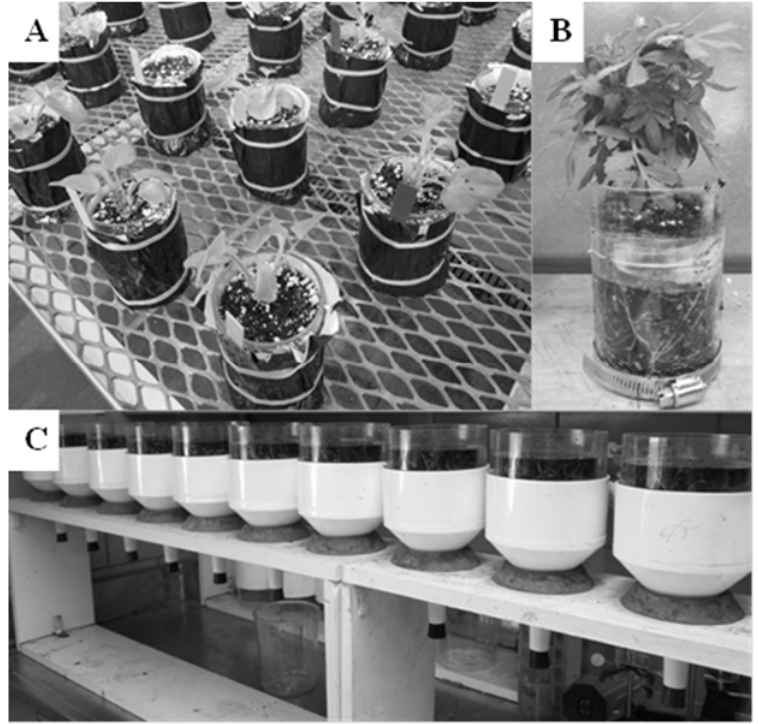
Figure 3. ( A ) Rhizometers covered with foil to prevent sunlight from reaching the rhizosphere are grown on a greenhouse bench; ( B ) Foil removed to view roots visible along the clear cylinder of the rhizometer; ( C ) Harvested rhizometers with shoots removed, in the North Carolina State University Porometer method [93] to measure substrate physical